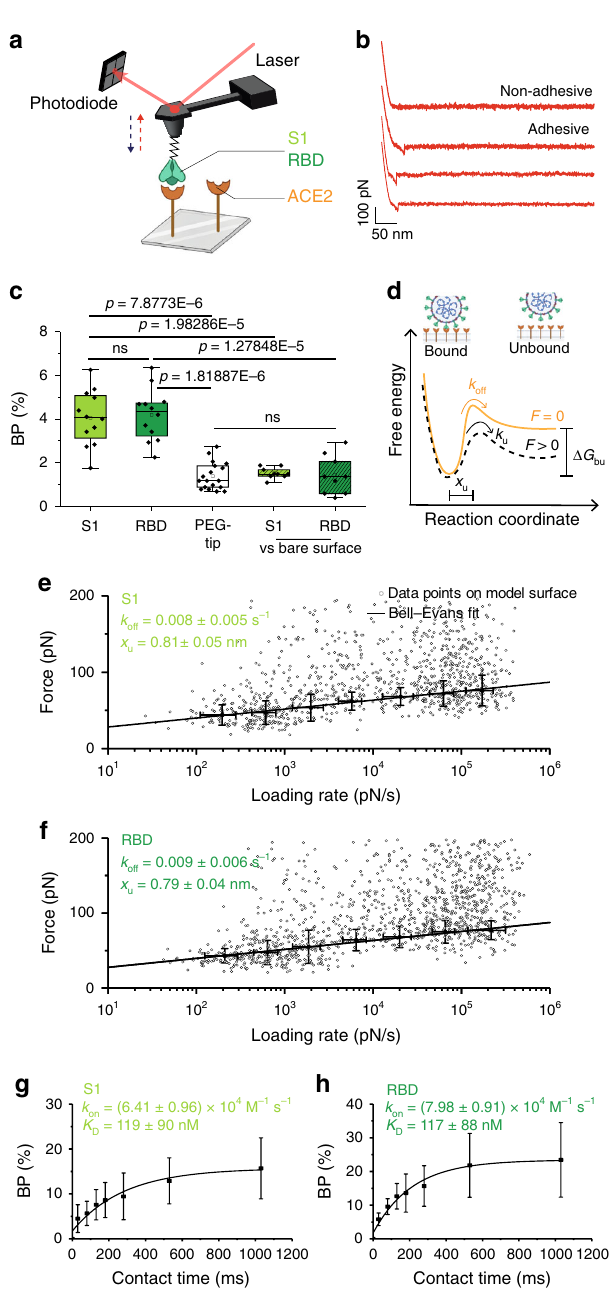
used FD-curve-based AFM to evaluate at the single-molecule level the binding strength of the interaction established between the glycosylated S1 subunit and ACE2 receptors on model surfaces (Fig. 2a). To mimic cell-surface receptors in vitro, ACE2 receptors were covalently immobilized onto gold surfaces coated with OH- and COOH-terminated alkanethiols using carbodiimide con- jugation (see Methods). These model surfaces were imaged by AFM, and the thickness of the grafted layer was validated by a scratching experiment, revealing a deposited layer of 6.1 ± 0.4 nm (mean ± S.D., N = 3) (see Methods and Supplementary Fig. 1). To study the interaction between the S1 subunit and the immobilized ACE2 receptors, we covalently grafted either the puri fi ed full S1 subunit or RBD only to the free end of a long polyethylene glycol (PEG) 24 spacer attached to the AFM tip 7 – 9 . To investigate the properties of the binding complex, force – distance (FD) curves were recorded by repeatedly approaching and withdrawing the